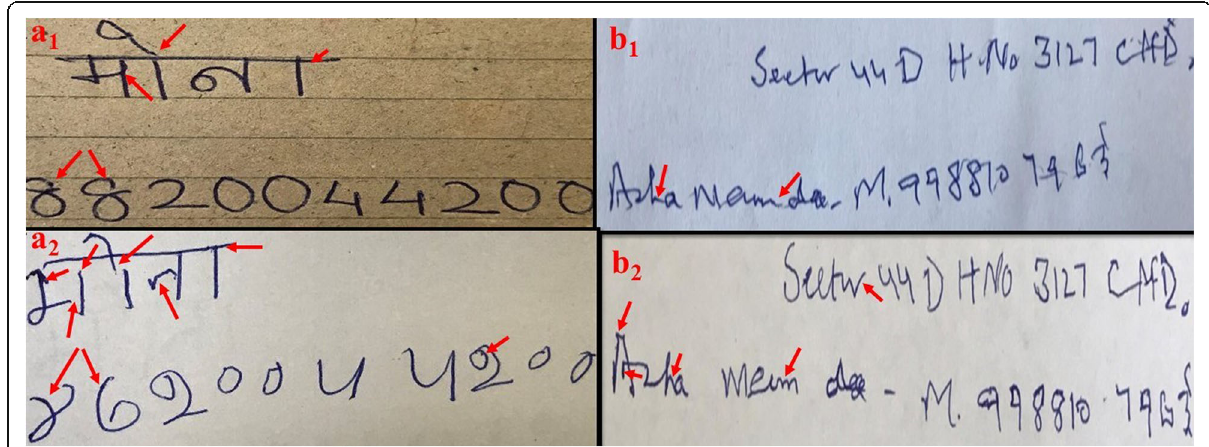
Fig. 6 Initial, terminal, and connecting strokes, simplification of words. a 1 Handwriting before onset of RA showing good quality of initial, terminal, and connecting strokes and no simplification. a 2 Simplified writing strokes, blunt initial and terminal strokes, and tremulous connecting strokes in handwriting of RA patient. b 1 Simplification of strokes and poor quality of initial, terminal, and connecting strokes in affected writing. b 2 Copied writing showing inability to simplify letters, hesitating initial and terminal strokes, and tremulous connecting